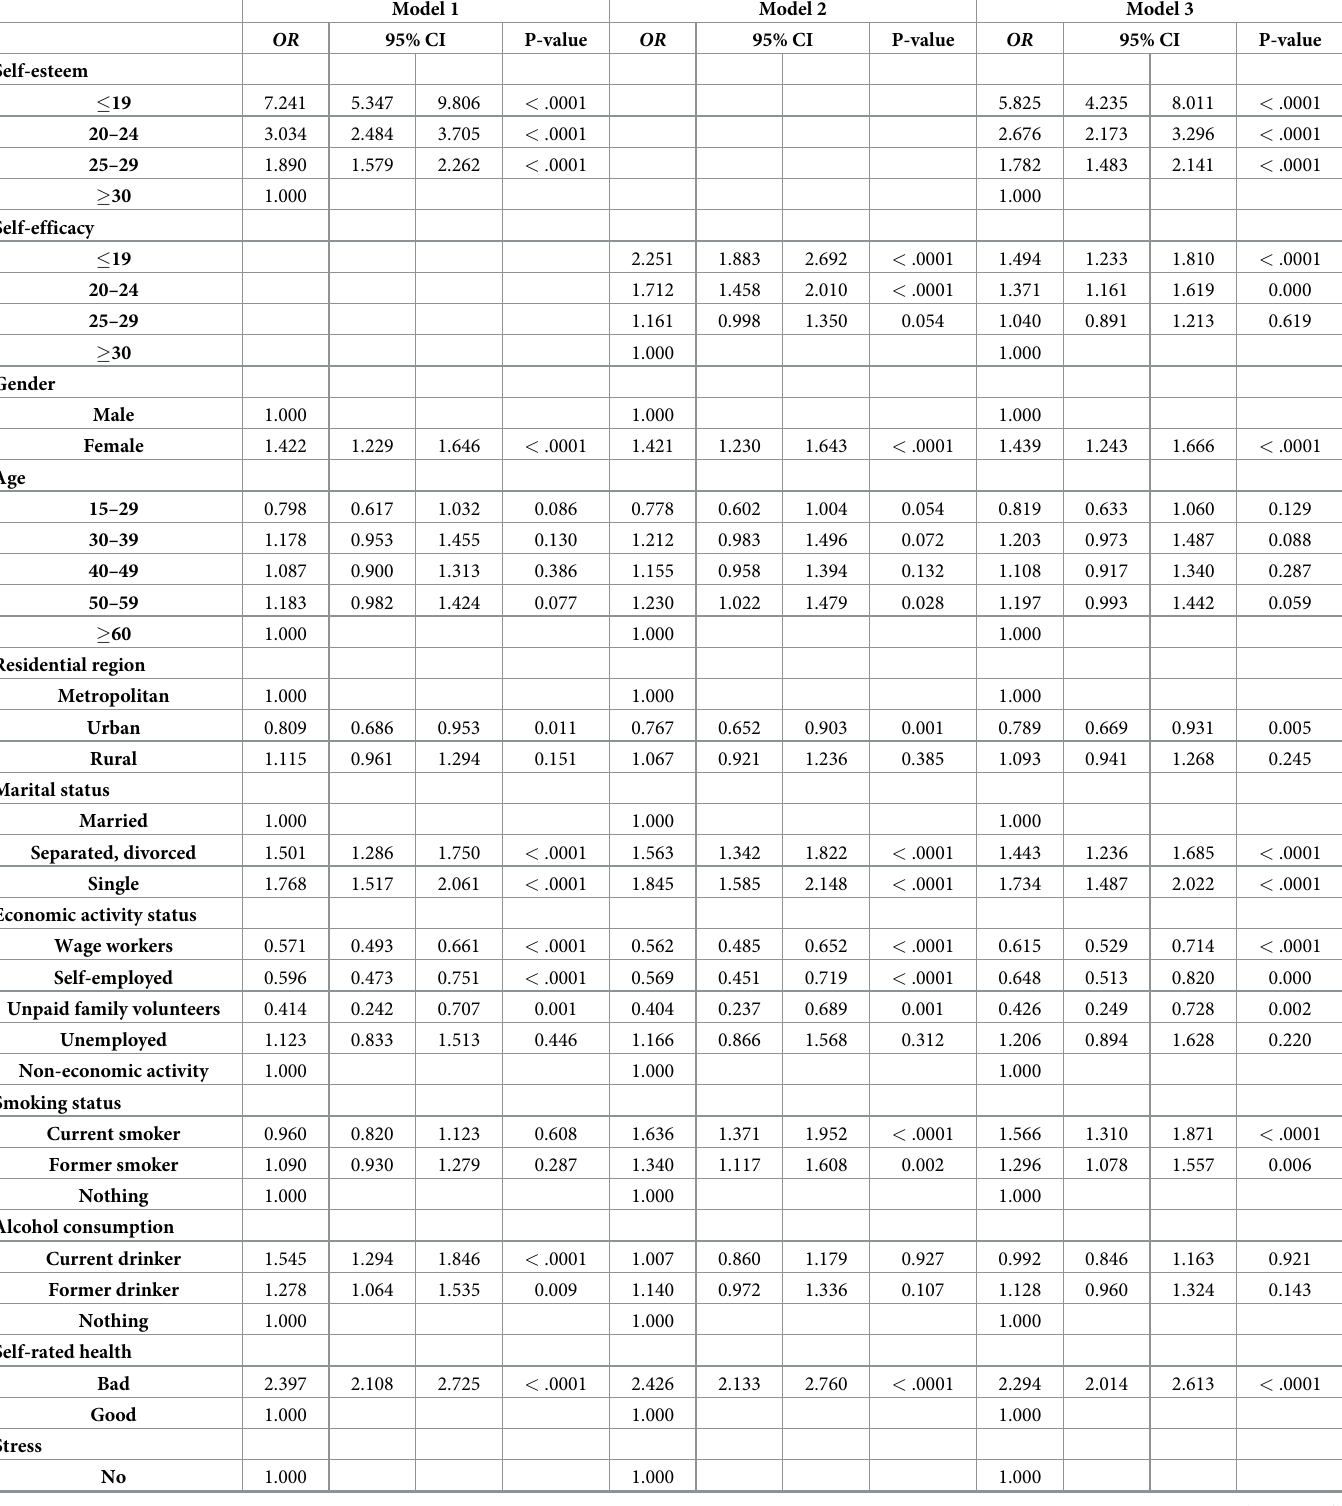
Table 2. Association between self-evaluation and self-report of